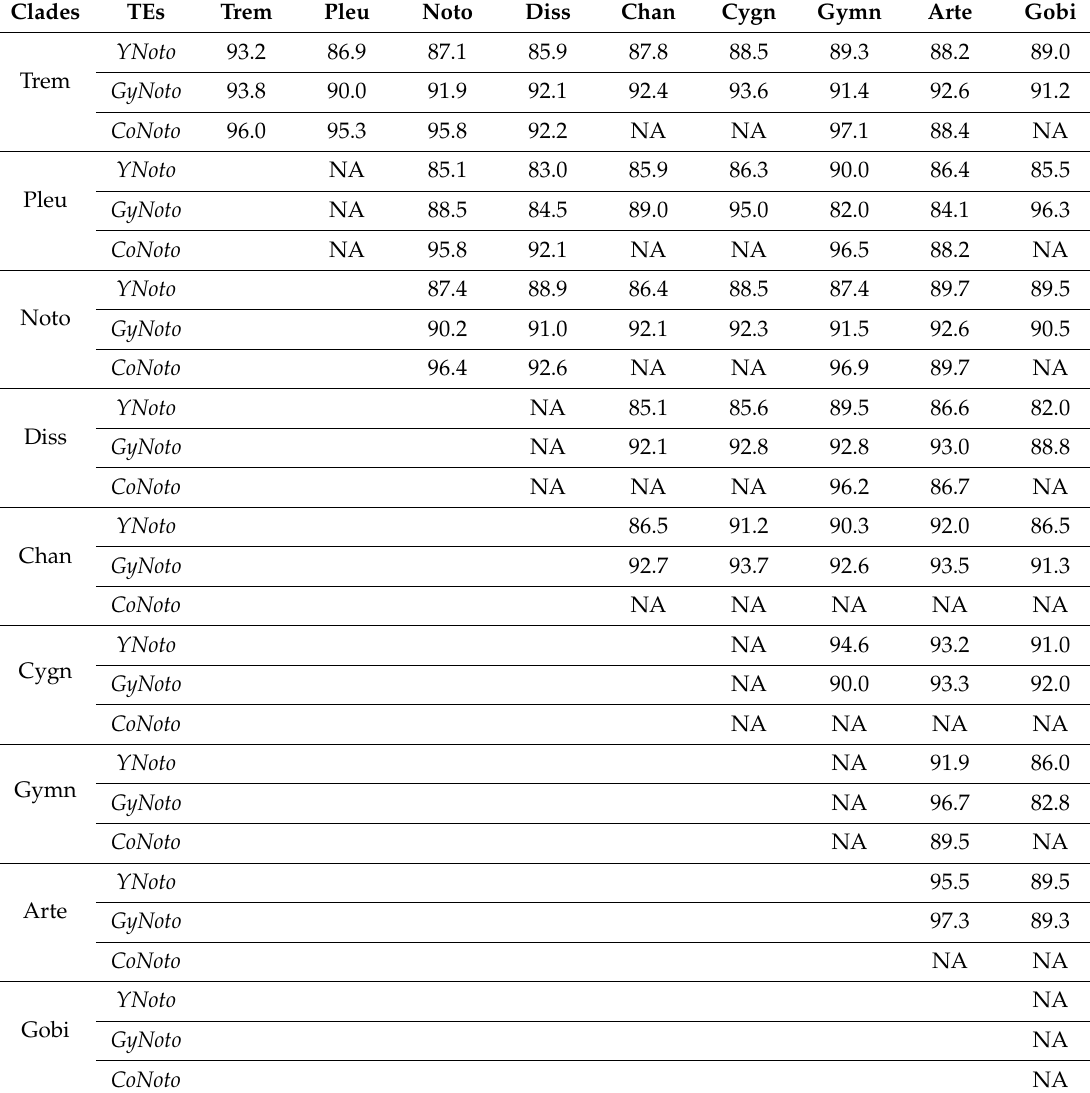
Table 2. TE intrafamily conservation within and across nototheniid